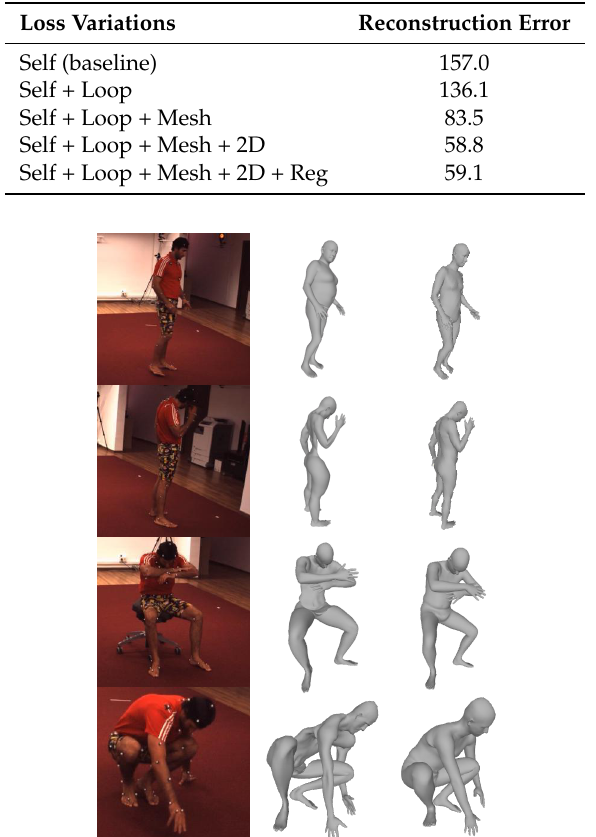
Figure 6. Input images ( left ), and the reconstruction results of using ( right ) and not using ( middle ) the regularization